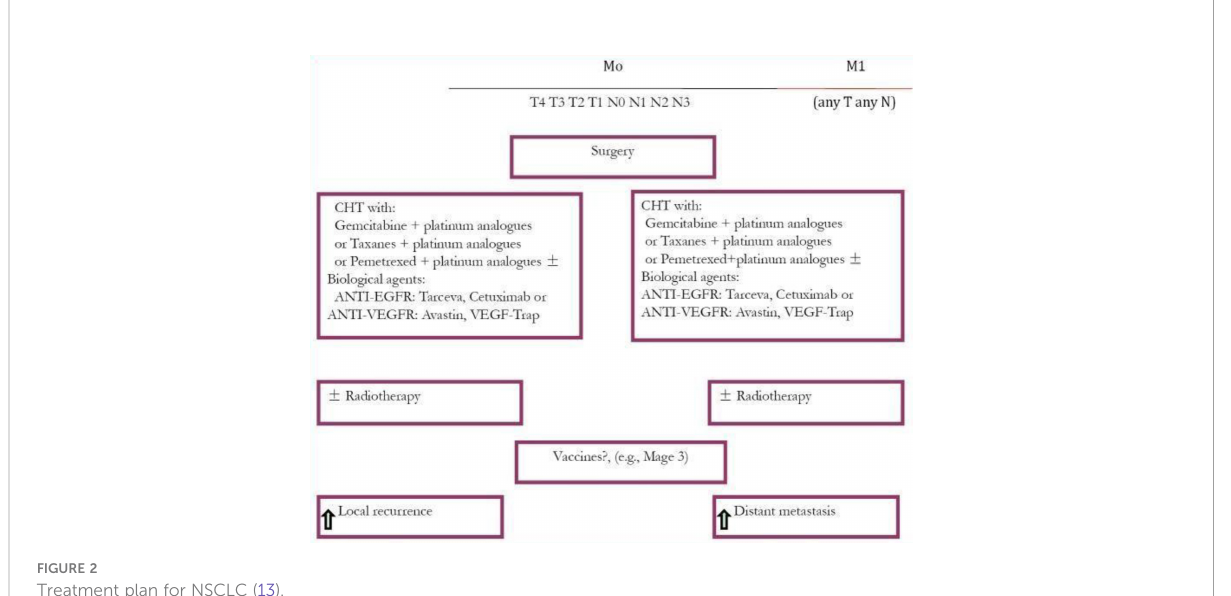
FIGURE 2 Treatment plan for NSCLC